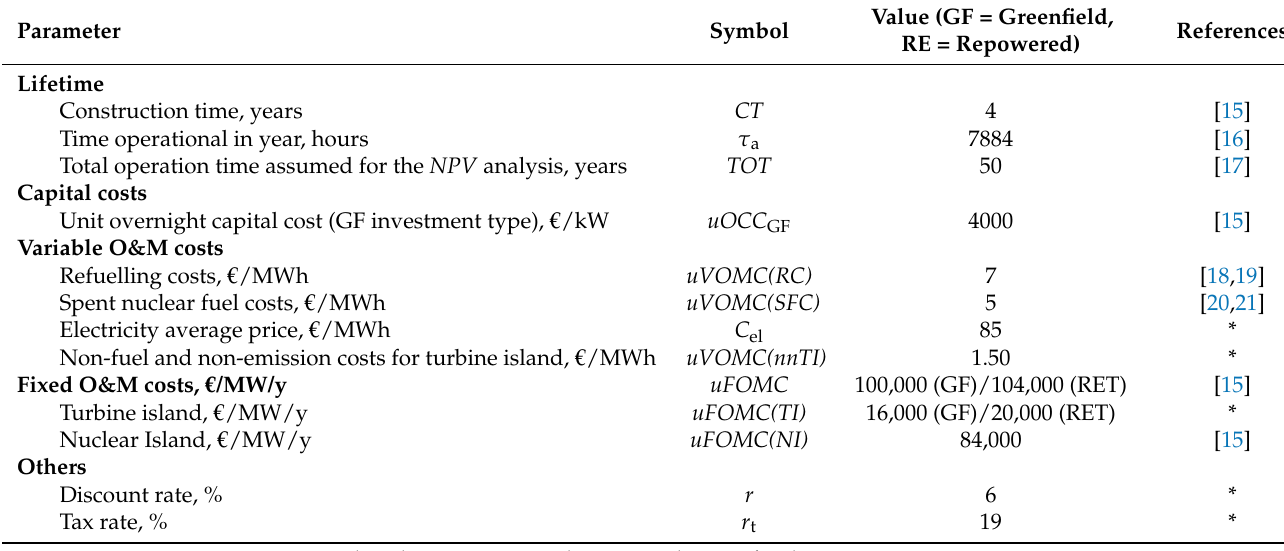
Table 6. Base economic parameter